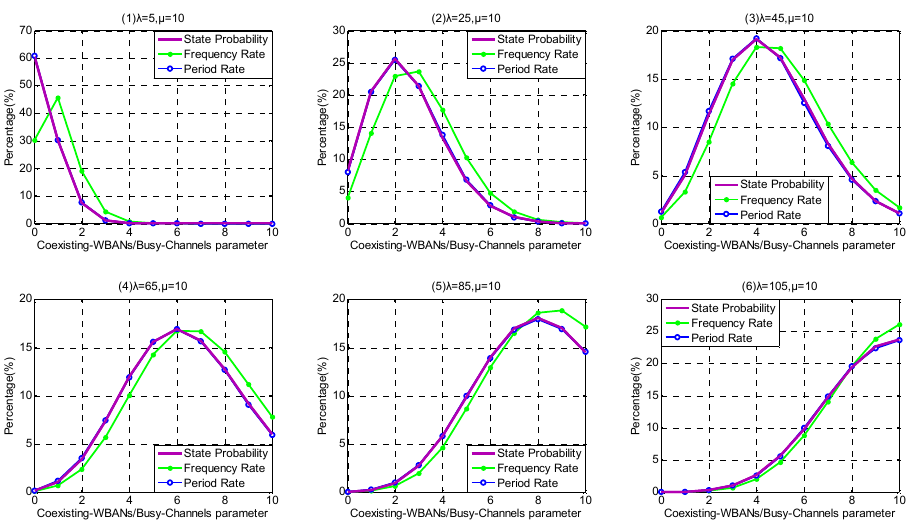
Figure 12. Coexisting-WBAN/Busy-channel Parameter probability distribution under 1-tolerated channel conflict model in Service-independent coexisting